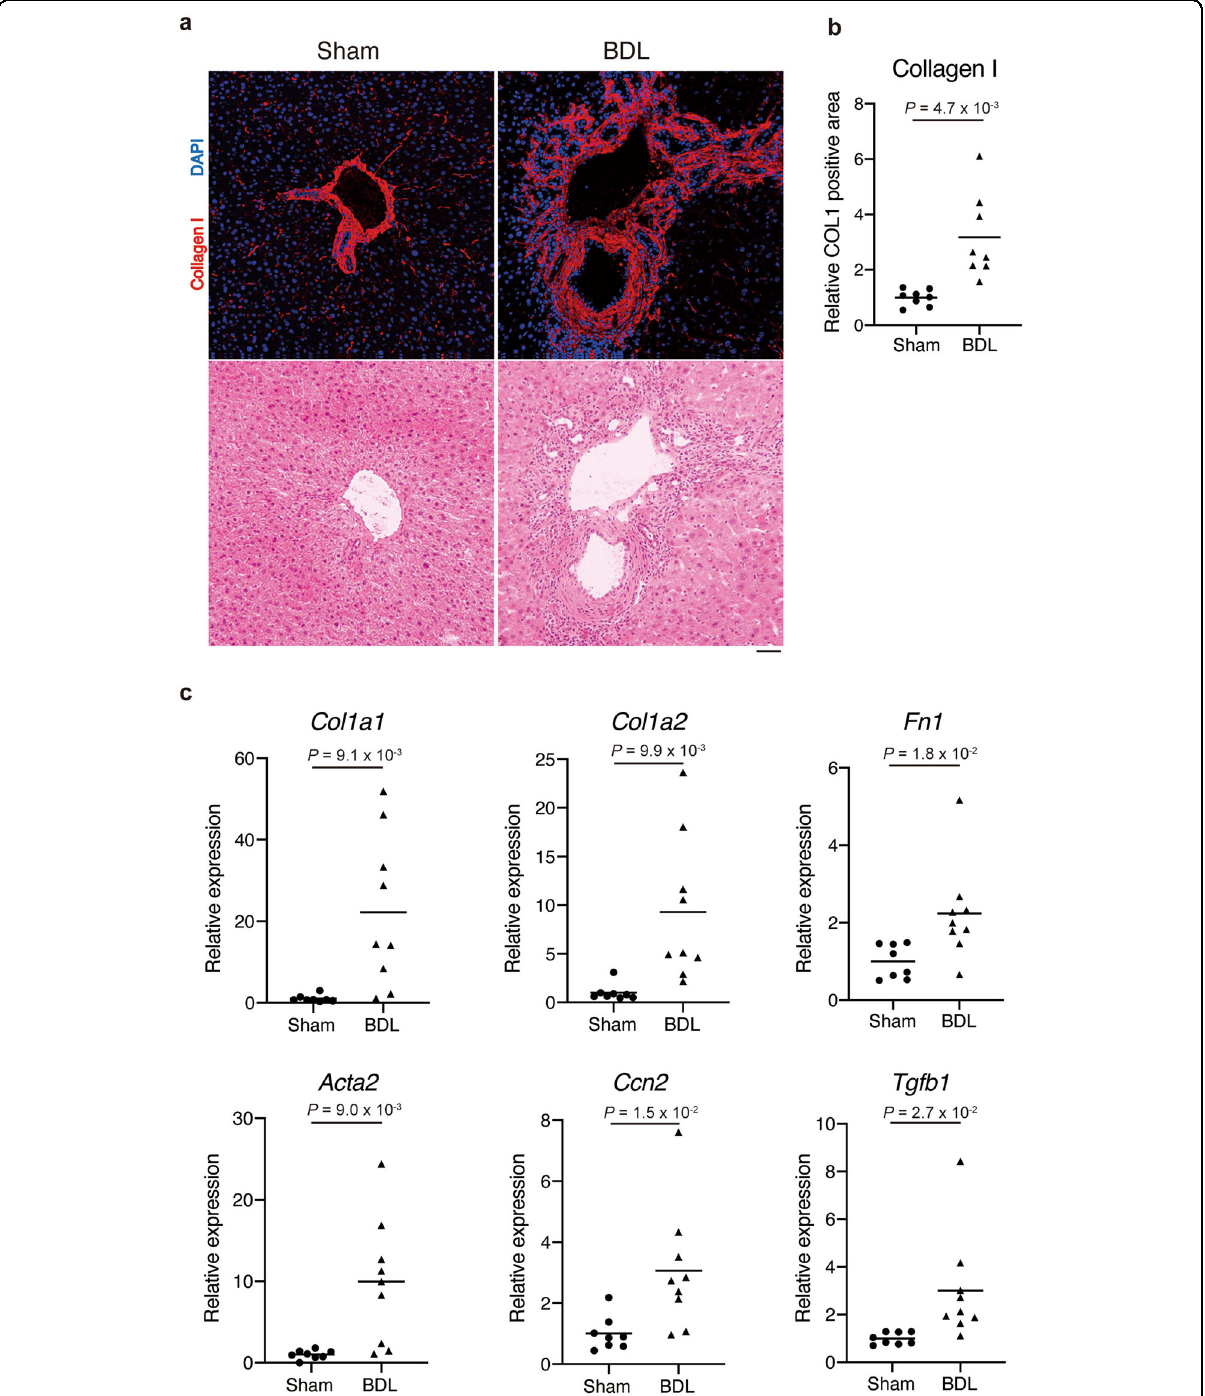
Fig. 1 BDL induces liver fi brosis in mice. The common bile duct of eight-week-old male mice was ligated to induce liver fi brosis. a The sections derived from livers excised on day 7 post-operation were subjected to immuno fl uorescence staining for collagen I and DAPI (upper) and subsequently to H&E staining (lower). b The collagen I-positive area was quanti fi ed. n = 8 mice for each group. c The hepatic expression levels of fi brosis-related genes ( Col1a1, Col1a2, Fn1, Acta2, Ccn2 , and Tgfb1 ) were quanti fi ed on day 7 post-operation. n = 8 mice for sham and n = 9 mice for BDL. Data represent individual data points and the means. Data were analysed using the two-sided unpaired t-test and Welch ’ s correction. Scale bar, 50 μ m ( a